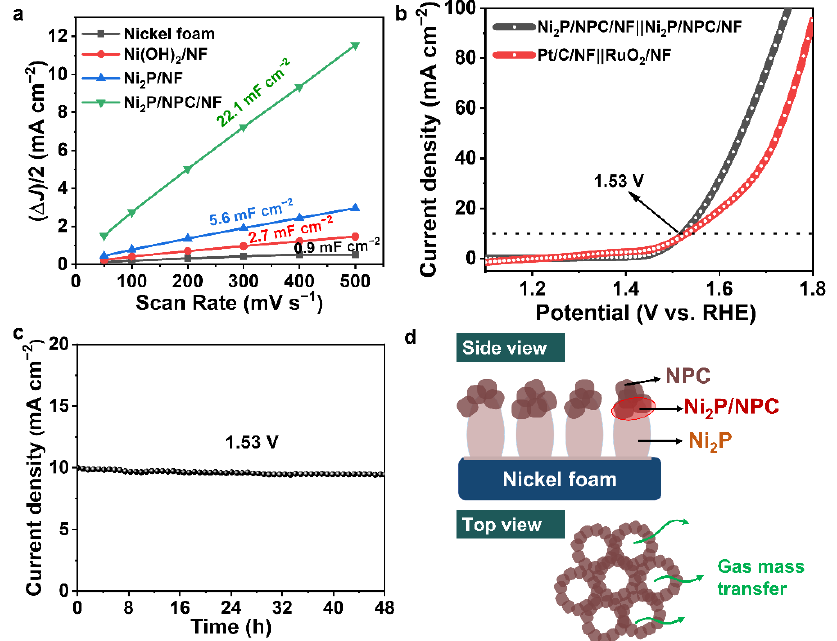
Figure 7. ( a ) Double-layer capacitance (C dl ) plots of nickel foam, Ni(OH) 2 /NF, Ni 2 P/NF Ni 2 P/NPC/NF samples. ( b ) Polarization curves of Ni 2 P/NPC/NF toward overall water splitting. ( c ) Chronoamperometric curve of Ni 2 P/NPC/NF at constant current densities of 10 mA cm − 2 for water splitting in 1.0 M KOH. ( d ) Coupling synergistic effect of Ni 2 P and NPC of Ni-MOF on in situ growth of nickel foam and formation of gas mass transfer channel.